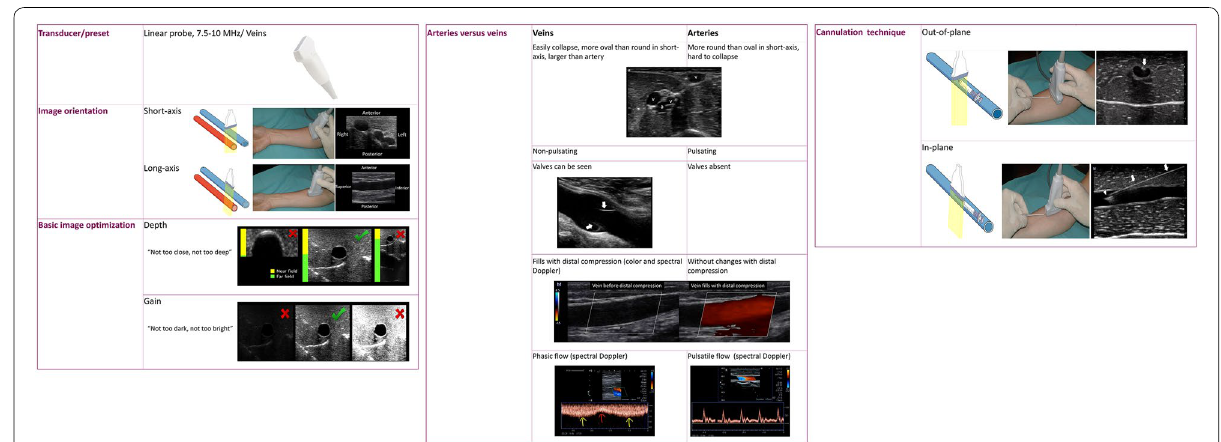
Fig. 1 Basic general knowledge for ultrasound-guided vascular cannulation: selection of the transducer and preset, image orientation, basic image optimization, distinguishing veins versus arteries and the two techniques of cannulation used in practice: the out-of-plane and the in-plane